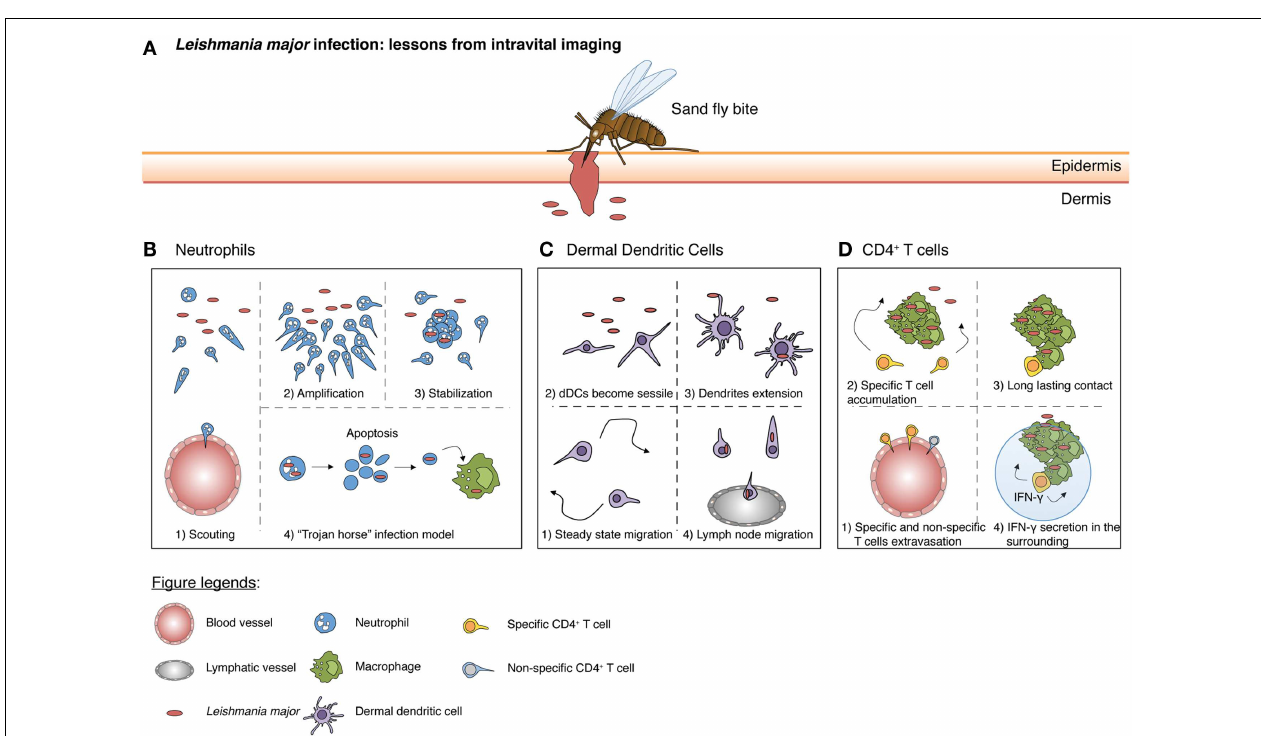
steady state, dDCs patrol the dermal layer. However, upon parasites inoculation, dDCs become sessile and extend their dendrites, picking up parasites from neutrophil apoptotic bodies or capturing free L. major in the environment. Ultimately, dDCs migrate to the draining lymph nodes where they present antigens and initiate aT cell response. (D) Around 1week after L. major deposition, antigen-specific CD4T-cells are generated and can migrate to the site of infection. Both antigen-specific and non-specific CD4T-cells can exit inflamed blood vessels, but only specific CD4T-cells accumulate at the site of infection. Finally, throughTCR/MHC-II interaction with infected macrophages, antigen-specific CD4T-cells are able to produce IFN- γ . Of note, IFN- γ can act not only through cell contact, but also on cells in the surrounding vicinity via the “by-stander” effect for enhanced pathogen